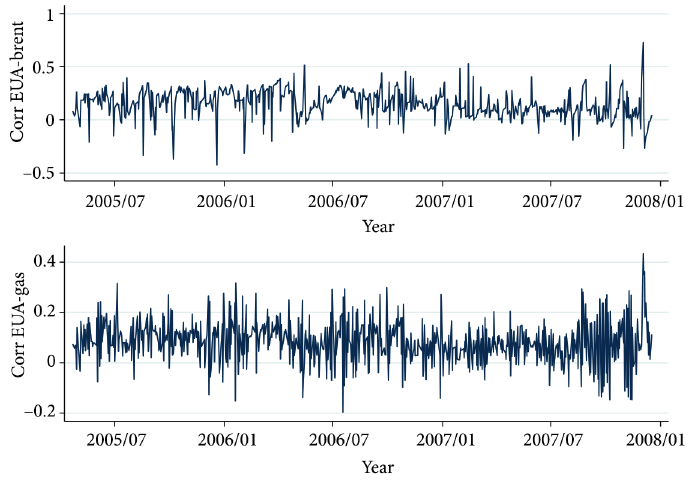
Figure 5. Dynamic correlation between the daily log returns of EUA and the energy futures from the phase I of EU ETS The dynamic correlation, which can be shown by Figure 5, extends the previous research- es about the correlation of EUA and the energy fundamentals. There is a positive correlation between the EUA and the energy futures in the first phase, but the correlation is not